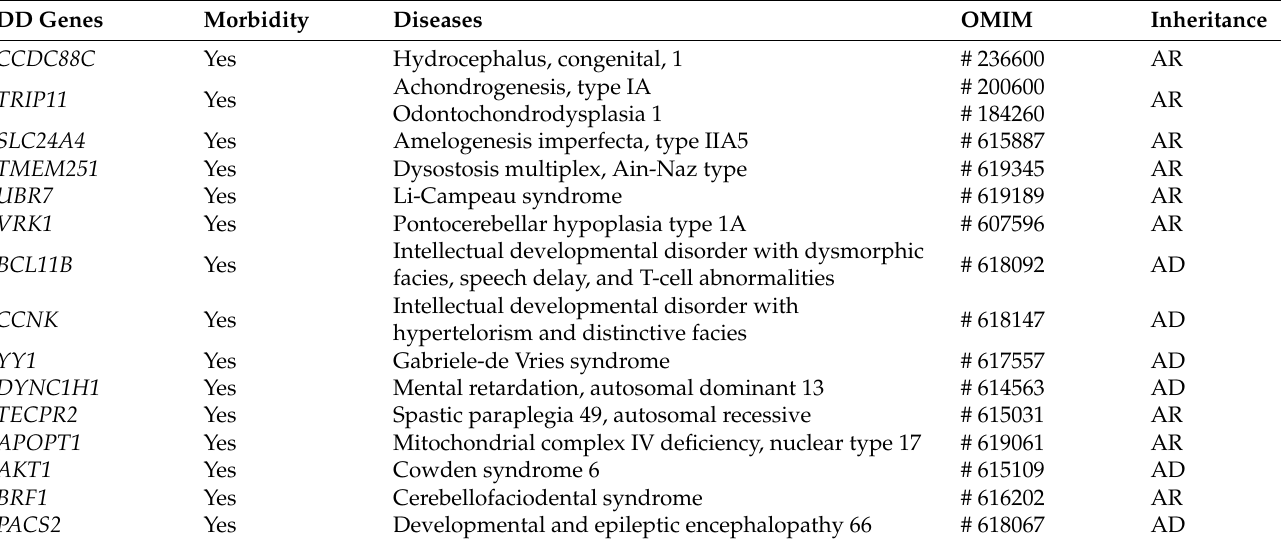
Table 1. Fifteen candidate genes associated with developmental delay located between 14q32 and